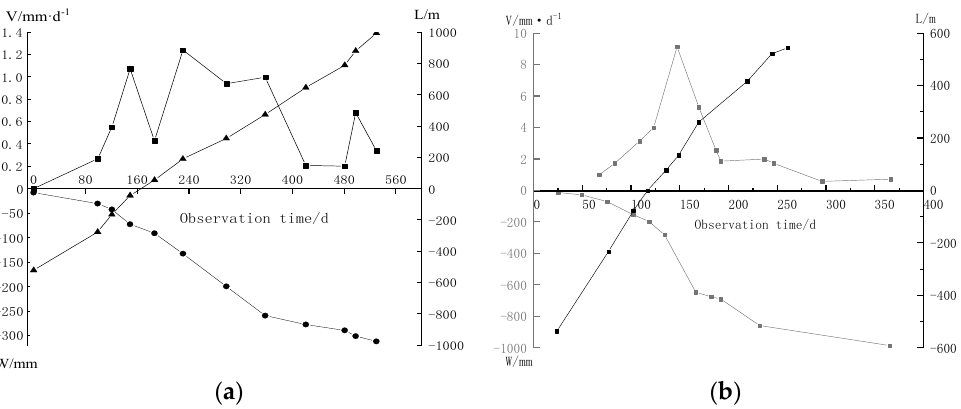
Figure 2. Subsidence velocity of maximum subsidence point of strike line; ( a ) C46 point in the Yingpanhao Coal Mine. ( b ) S30 point in Jining Well 2.